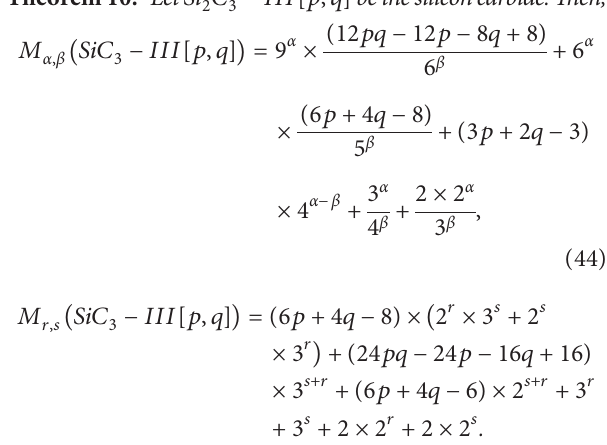
Figure 12: 2 D structure of SiC − I [ 5 , 2 ] (b) SiC 3